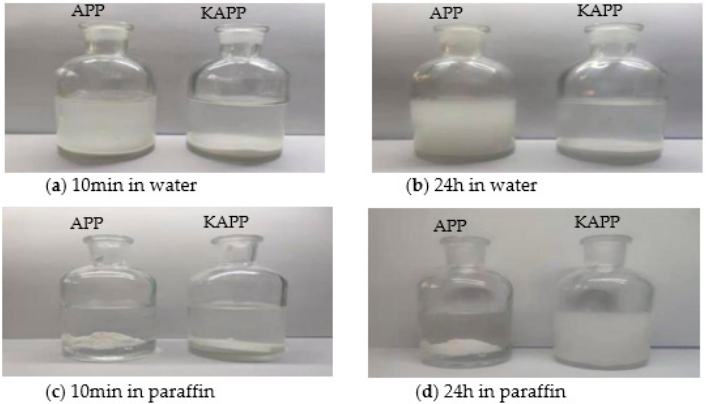
Figure 2. shows photographs of APP and KAPP powders placed in different solvents (distilled water, paraffin) for different durations. ( a ) APP with KAPP 10 min in water;( b ) APP with KAPP 24 h in water; ( c ) APP with KAPP 10 min in paraffin; ( d ) APP with KAPP 24 h in paraffin.